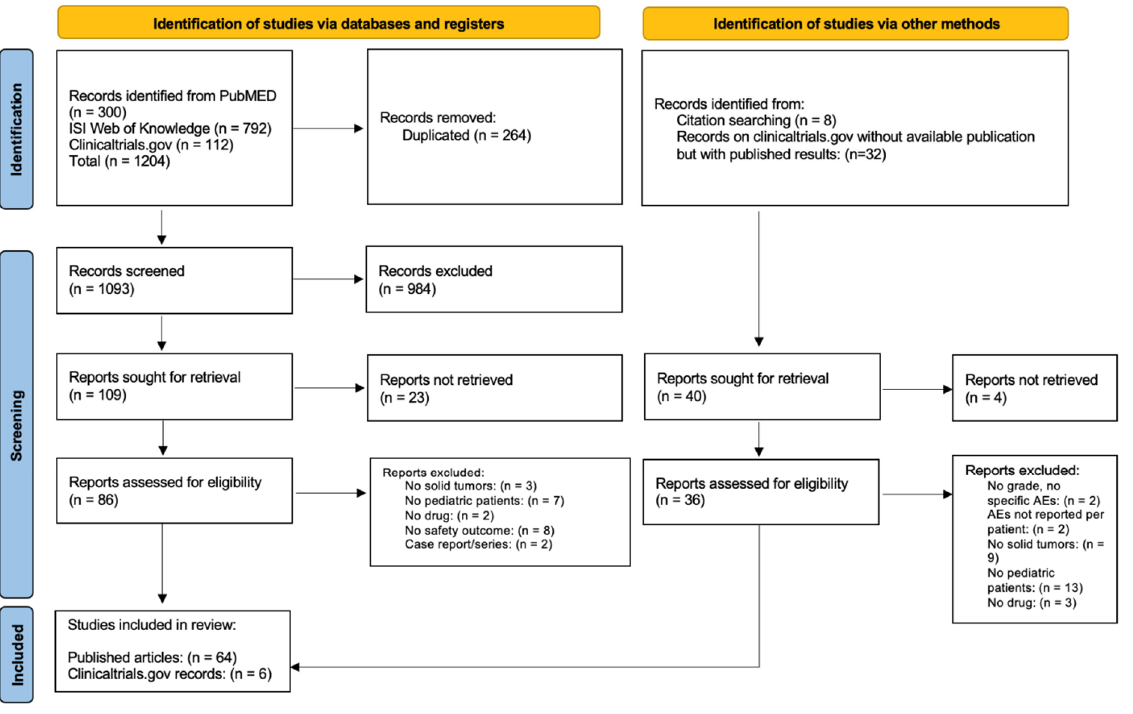
Figure 1. Prisma flow diagram.